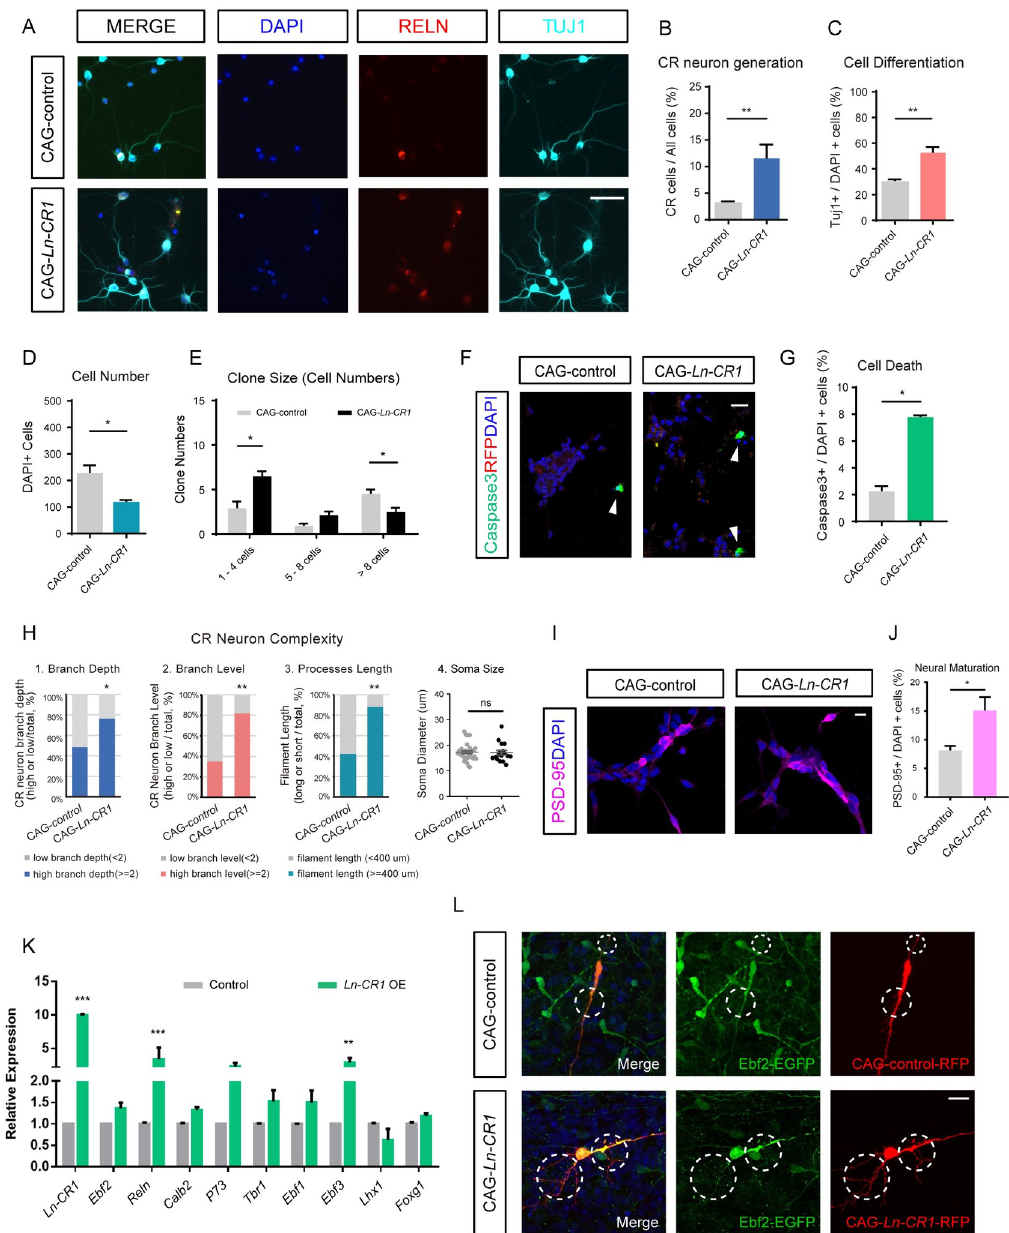
Fig 4. Functional validation of CR-specific lncRNAs Ln-CR1 in vitro and in vivo . (A) Immunostaining of neural cells treated with control (CAG-control) or overexpression lentiviruses for CR-specific lncRNA Ln-CR1 (CAG- Ln-CR1 ) after in vitro culture for 5 days. RELN (red), TUJ1 (cyan), or DAPI (blue) for CR neurons, neurons, and nucleus, respectively. Scale bar, 50 μ m. (B-G) Overexpression of CR-specific lncRNA Ln-CR1 significantly increased CR neurons number, promoted NSC differentiation, generated more neuron-like small cell clones and also increased cell apoptosis. Caspase3 (green), DAPI (blue) for apoptotic cells (arrowheads) and nucleus, respectively. Scale bar, 20 μ m. All the experiments were performed at least 3 times, and 6 randomly selected microscopy fields were counted each time. Data represented mean ± SEM. P values indicated were calculated by Student’s t test (unpaired). �� p < 0.01, � p < 0.05. (H) Quantification of process branch depth, branch levels, total dendrites length and soma size of CR neurons after overexpression of CR-specific lncRNA Ln-CR1 compared to control. All the experiments were performed 3 times, and 8 randomly selected microscopy fields were counted each time. Data represented mean ± SEM. p values indicated were calculated by Student’s t test (unpaired). �� p < 0.01, � p < 0.05. (I-J) Immunostaining of neural cells treated with control (CAG-control) or overexpression lentiviruses for CR-specific lncRNA Ln- CR1 (CAG- Ln-CR1 ) after in vitro culture for 5 days shown more mature neurons in Ln-CR1 overexpression group. PSD-95 (magenta), DAPI (blue) for mature neurons and nucleus, respectively. Scale bar, 10 μ m. The experiments were performed at